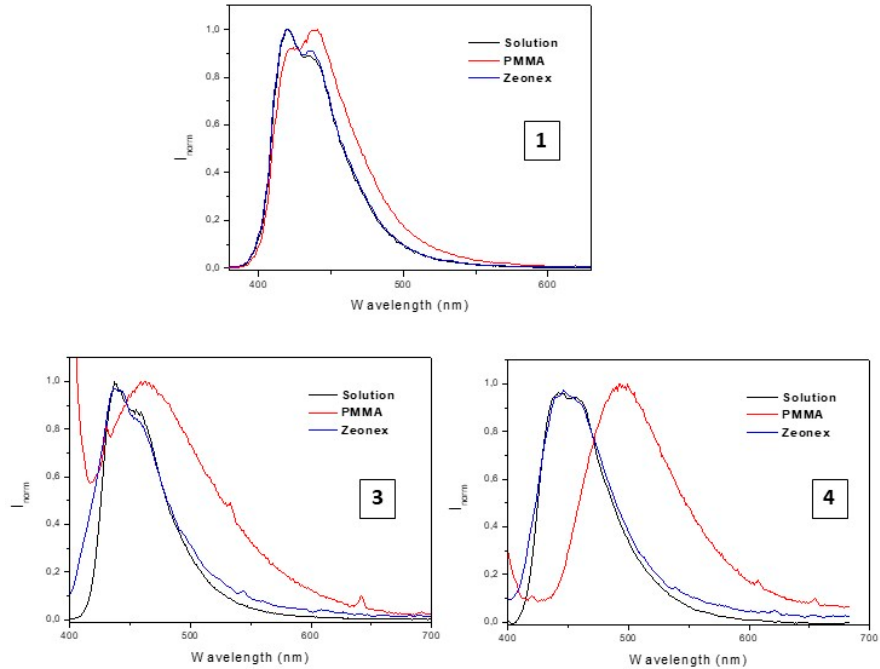
Figure 4. Normalized emission spectra of 1 , 3 , and 4 in 10 − 5 M dichloromethane solution and in solid matrixes of PPMA and Zeonex.